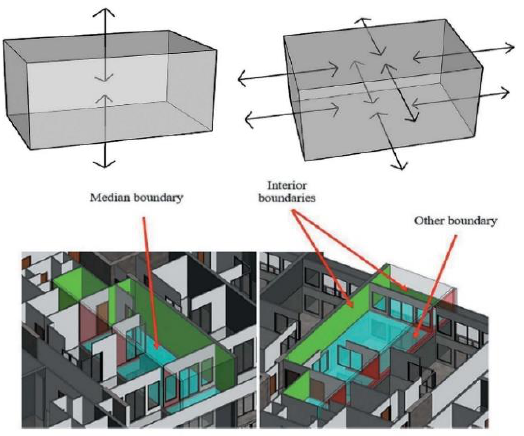
Figure 2 . Propagated vertical and horizontal rays with resulting legal boundaries of 3D units (Barzegar et al., 2020).